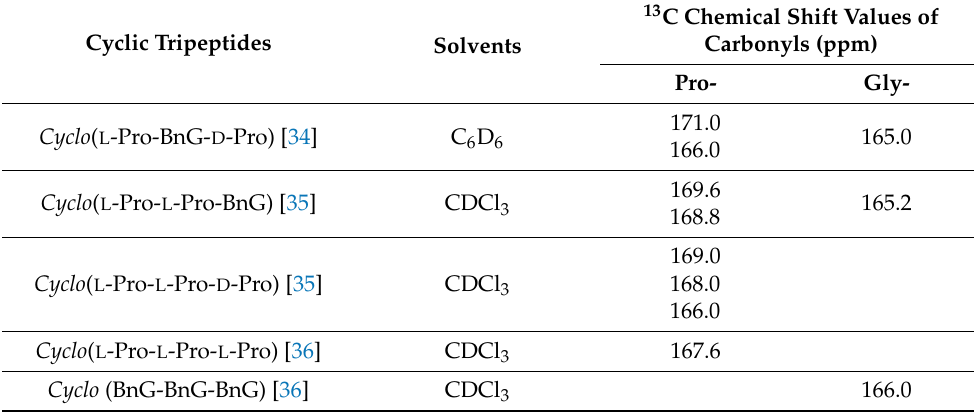
13 C Chemical Shift Values of Carbonyls (ppm) Pro- Gly-